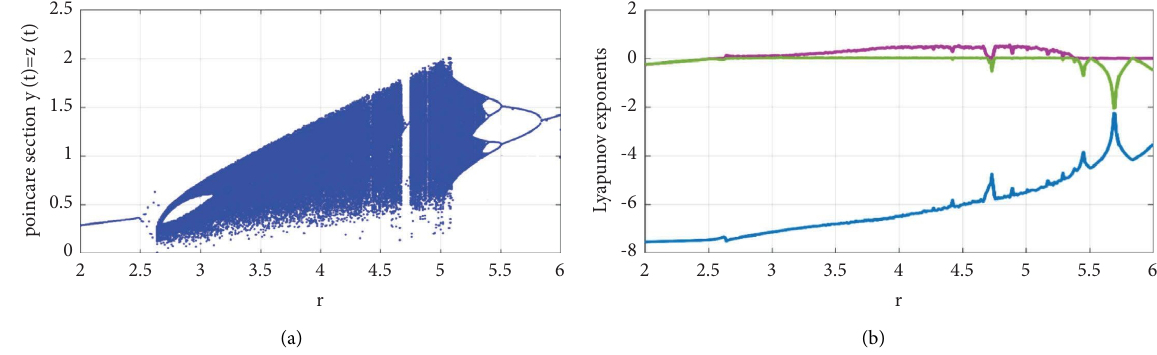
Figure 5: (a) Te system bifurcation diagram and (b) the corresponding Lyapunov exponents, utilizing r as a bifurcation parameter with fxing the other parameters constant such that a � 2 ,b � 7 , c � 5 , f � 8 , and g � 11. 00.511.5